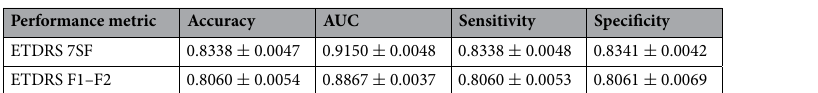
Table 1. The sensitivity, specificity, accuracy, and AUC results of the DR detection system using ETDRS 7SF and F1–F2 fundus images. The values are represented as the form of µ ± σ , where µ and σ denote the mean and standard deviation,